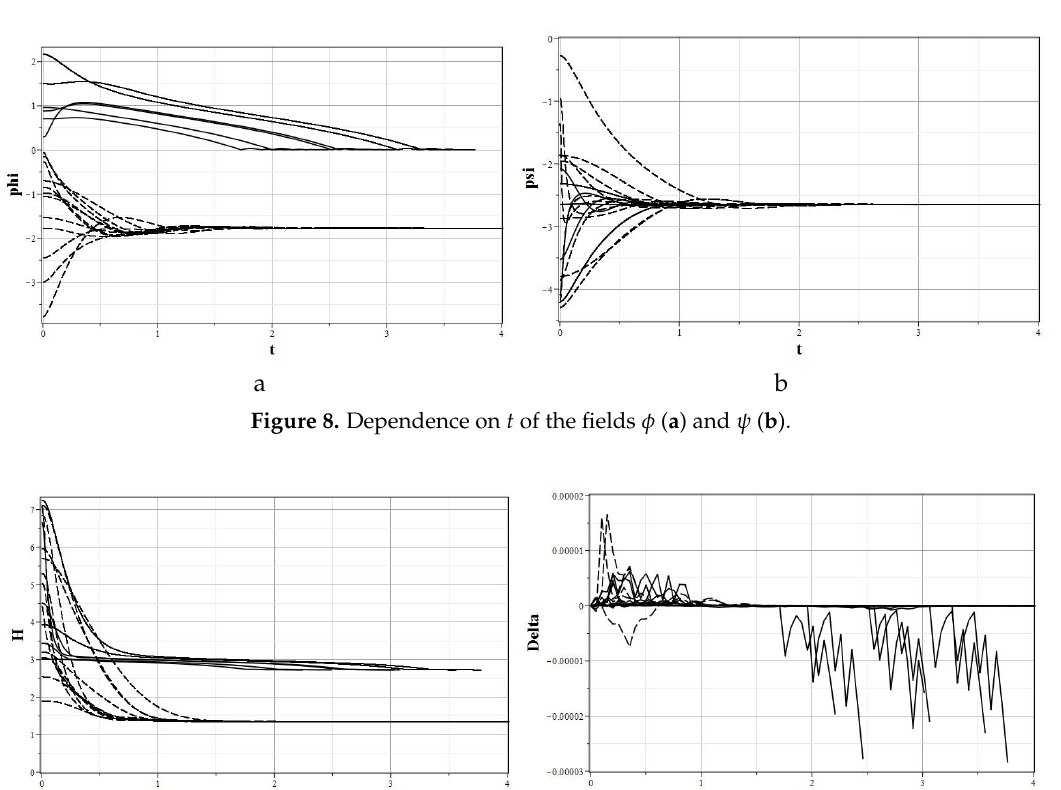
Figure 7. Isolines of the interaction potential (47) together with the phase trajectories of the model.